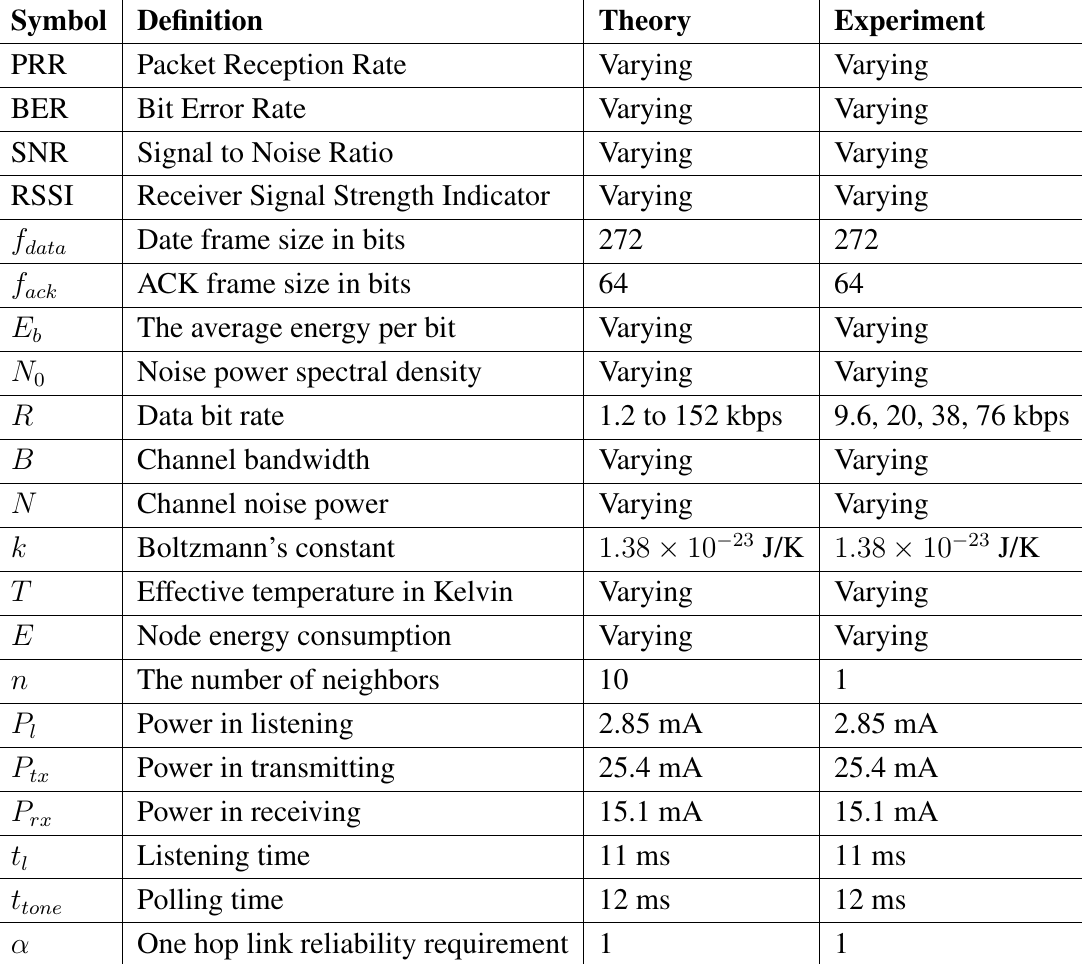
Table 1 . Mathematical notations and their values used in theoretical analysis and